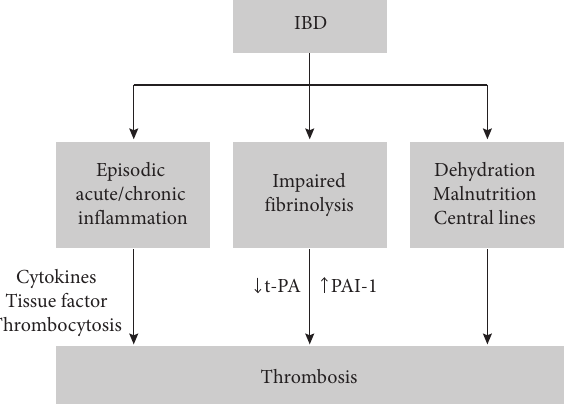
Figure 4: Mechanisms of thrombosis in IBD patients